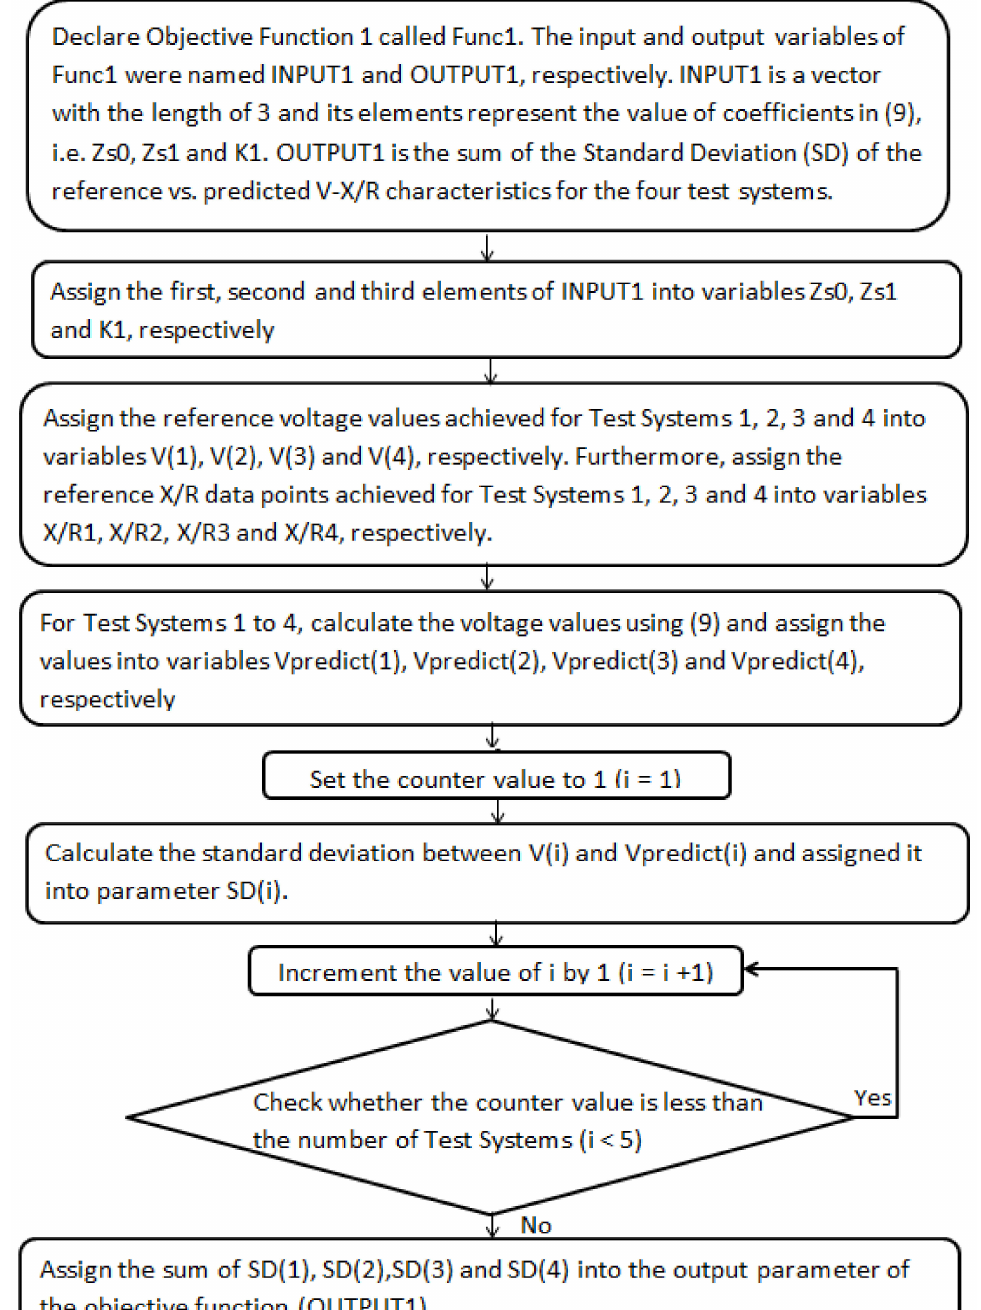
Figure 5. Flowchart diagram of